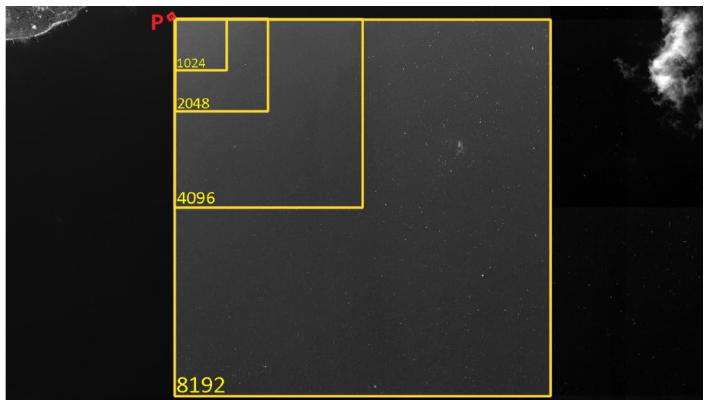
Figure 3. Fragment of the test satellite image. Fragments of different sizes used to retrieve the spectra are marked with yellow. The hydrophysical platform is marked with red.